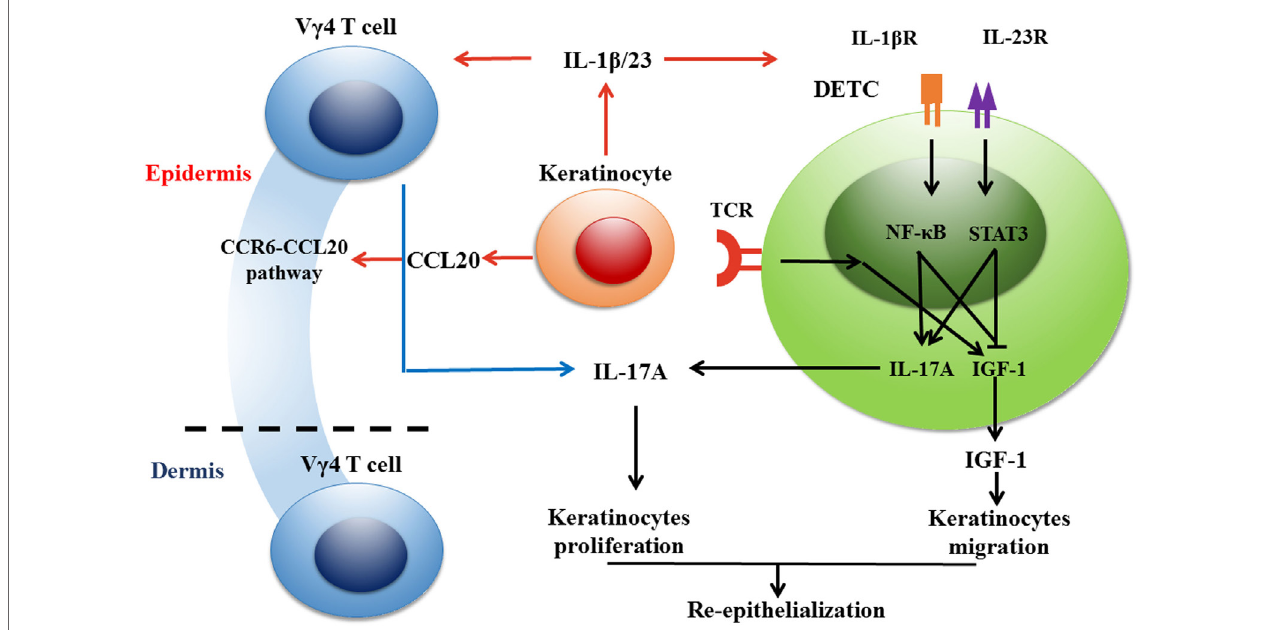
FiGURe 2 | V γ 4 T cells inhibit the production of IGF-1 in dendritic epidermal T cells (DETCs) via IL-17A-IL-1 β /IL-23 loop and thereby delay wound healing in normal mice. Once keratinocytes get stressed or damaged, DETCs are activated quickly through TCRs by sensing some as-yet-unknown antigens expressed by damaged keratinocytes in a non-major histocompatibility complex restricted manner. Dermal V γ 4 T cells are attracted to the epidermis around wounds by CCL20, which is increased in wounded epidermis, and provide an early source of IL-17A to delay skin wound healing. IL-17 secreted by V γ 4 T cells inhibits IGF-1 production by DETCs in an indirective way where IL-1 β and IL-23 produced by keratinocytes act as the bridge between them. IL-1 β and IL-23 are key cytokines to suppress IGF-1 production by DETCs. Besides, V γ 4 T cell-derived IL-17A facilitates keratinocytes to secrete IL-1 β and IL-23, and thus forms a positive feedback with keratinocyte- derived IL-1 β and IL-23. It is worthy to note that IL-1 β is more effective than IL-23 in our investigation. NF- κ B pathway plays a crucial role in IL-1 β -suppressed IGF-1 expression in DETCs. In conclusion, for wounds in normal mice, V γ 4 T cell-mediated IL-17A-IL-1 β /IL-23 loop has a negative impact on IGF-1 production by DETCs and thereby delays skin wound